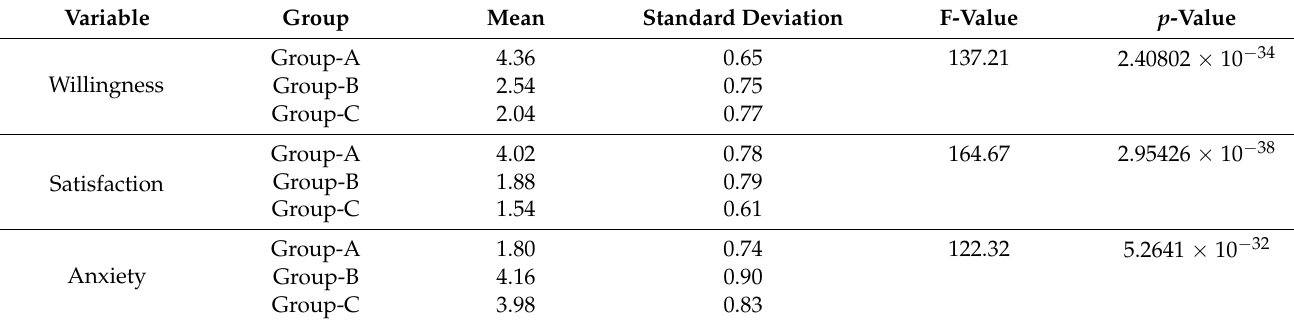
Table 2. Record of the One-way ANOVA tests conducted for students’ attitudes in different groups.